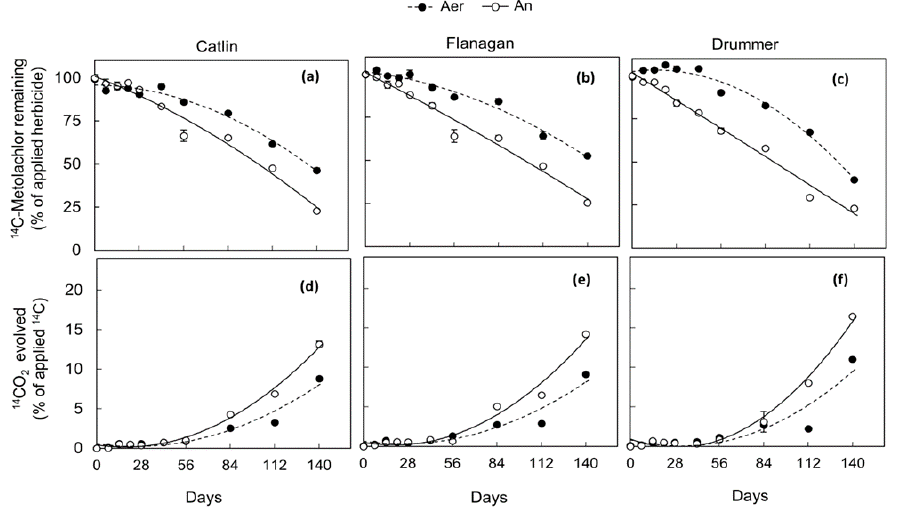
Figure 2. Degradation kinetics ( a – c ) and mineralization patterns ( d – f ) of 14 C-metolachlor in aerobic (Aer) and anaerobic (An) soil conditions in Catlin, Flanagan, and Drummer soils. Error bars, whenever visible, represent standard errors ( n = 3).